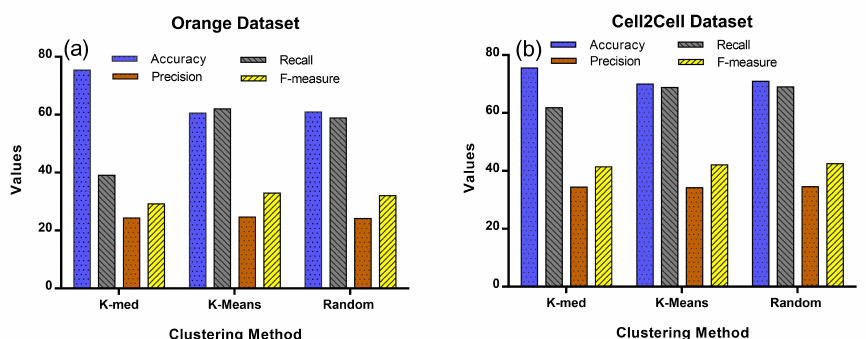
Figure 2. ( a ) Results analysis using single clustering methods on the Orange dataset. ( b ) Results analysis using single clustering methods on Cell2Cell dataset.